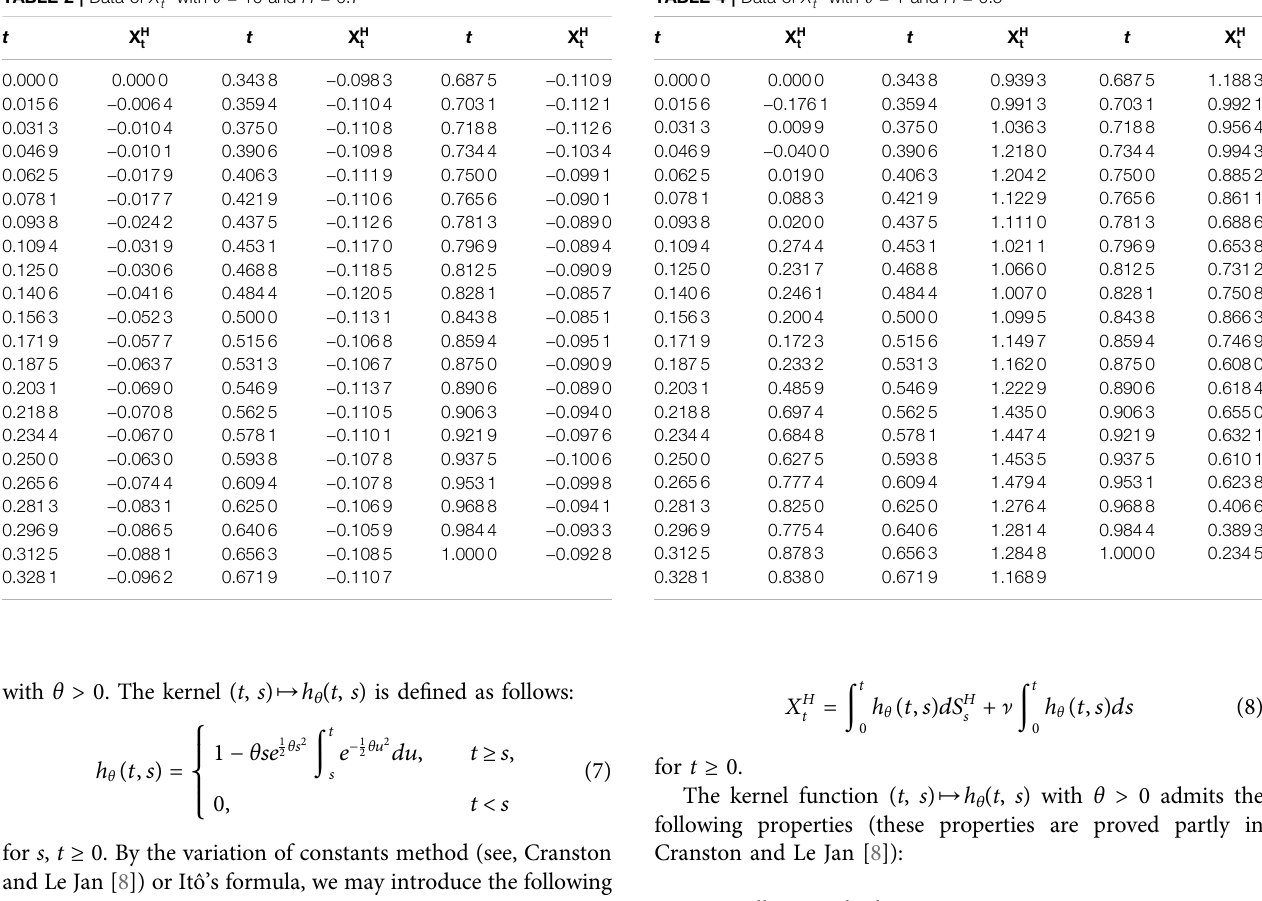
TABLE 4 | Data of X H t with θ (cid:1) 1 and H (cid:1)